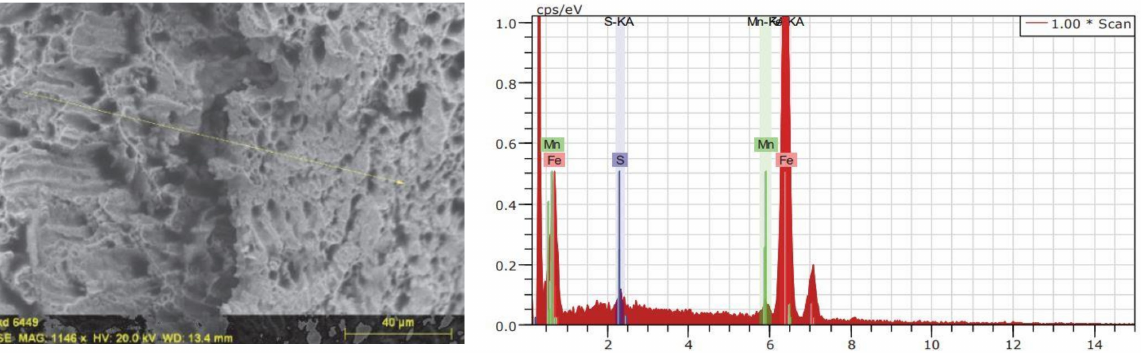
Figure 7. SEM and EDX analyses of a non-corroded sample of Tempcore steel B [57].